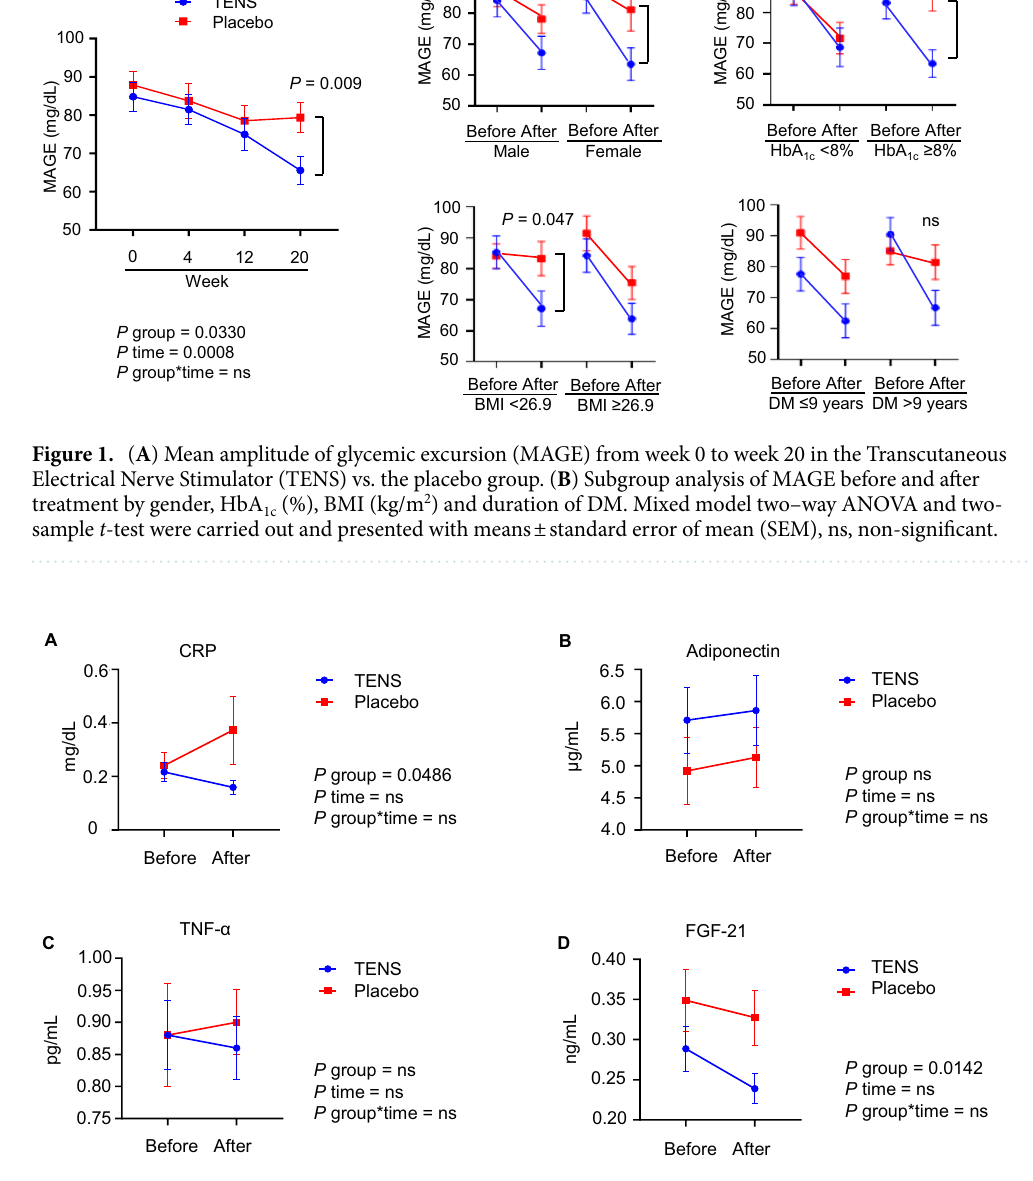
14 events by nine subjects in placebo group (30%) and six events by five subjects in the TENS group (11%). Five subjects had experienced hypoglycemia more than once, including four subjects in the placebo group and one subject in the TENS group. Three (4%) subjects in the placebo group encountered hyperglycemia requiring rescue insulin therapy, and one (1%) subject in the TENS group had hyperglycemia being rescued by add-on OAD. One patient in the TENS group experienced redness, swelling and pain on abdominal wall which completely resolved spontaneously without specific treatment. Finally, the insulin levels did not differ significantly during the treatment course between the TENS group and the placebo group (Supplementary Table S16). With further analyses of homeostasis model assessment of β-cell function (HOMA-β) and insulin resistance (HOMA-IR) (Supplementary Figure S3), we concluded that islet cell function was not affected by using TENS (two-sample t -test showed non-significant difference at week